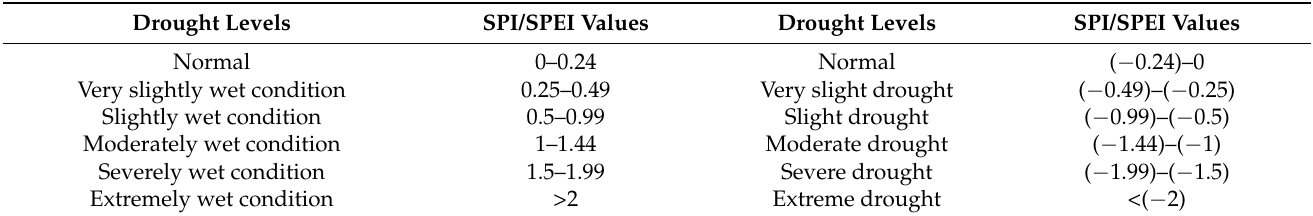
Table 1. The classification of drought and wetness according to the SPI and SPEI